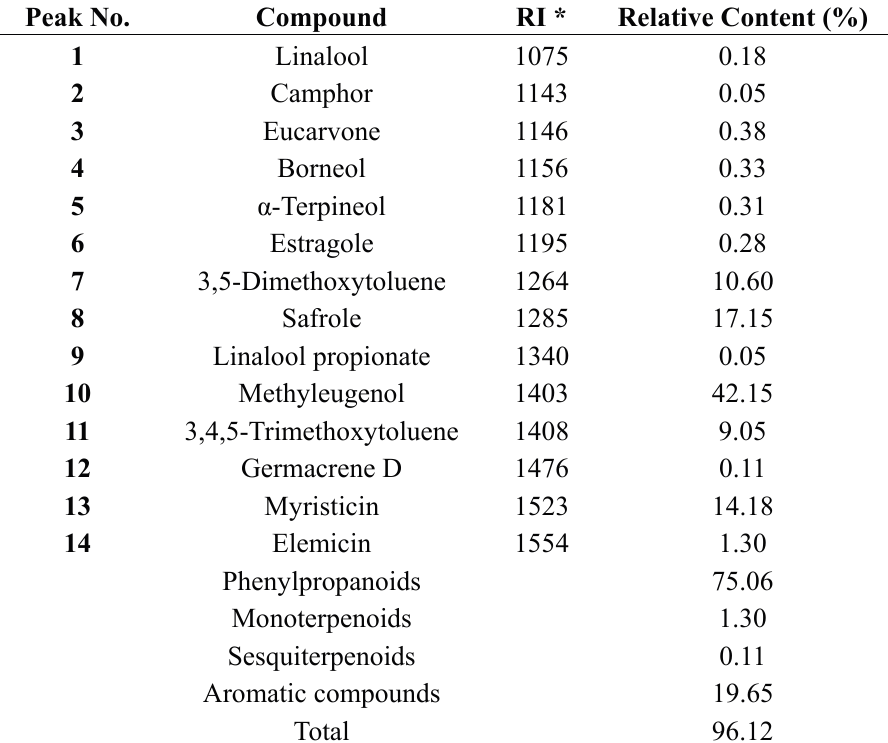
Table 1. The analyses revealed 14 components, representing 96.12% of the oil. The main components were methyl eugenol (42.15%), safrole (17.15%), myristicin (14.18%), 3,5-dimethoxytoluene (10.60%) and 3,4,5-trimethoxytoluene (9.05%). Table 1. Chemical composition of Liriope muscari essential oil. Peak No.